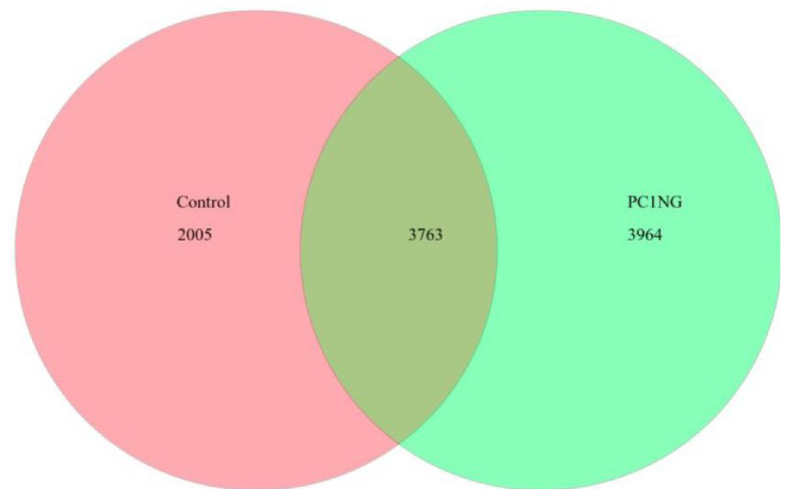
Fig 2. OTU Venn diagram of control and treated soil